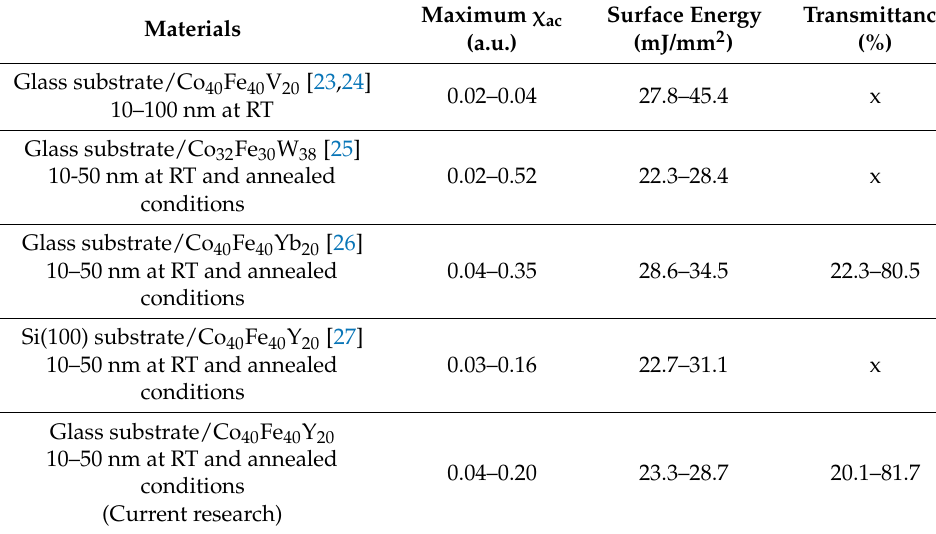
Table 2. Significant properties for CoFeV, CoFeW, and CoFeYb